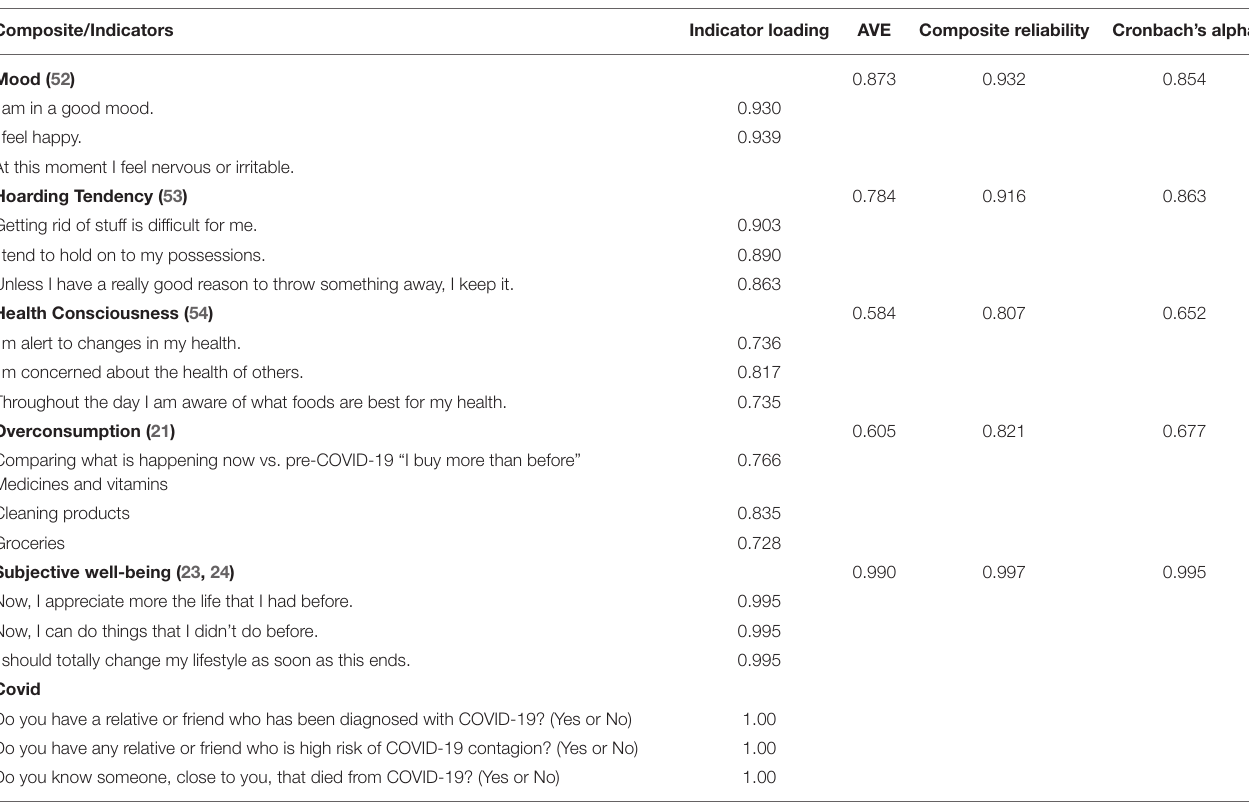
TABLE 2 | Study’s measures and indicators.